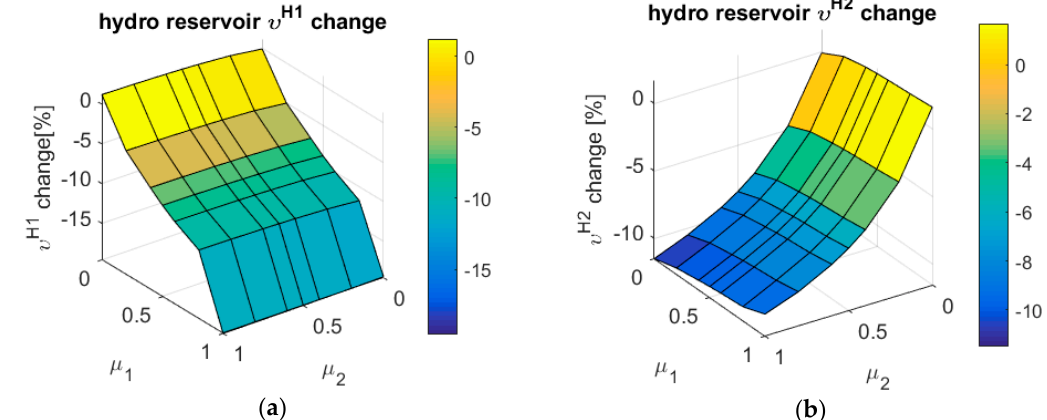
Figure 7. Hydro reservoir relative change in the period t 3 for Genco1 ( a ) and Genco2 ( b ).